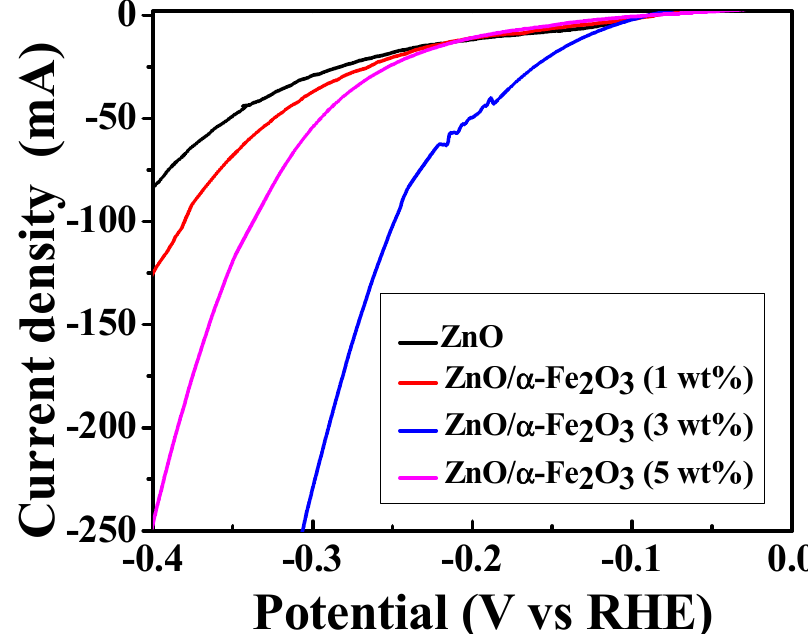
Figure 7. Hydrogen evolution reaction (HER) activity of ZnO; ZnO / α -Fe 2 O 3 (1 wt%); ZnO / α -Fe 2 O 3 (3 wt%); and ZnO / α -Fe 2 O 3 (5 wt%).